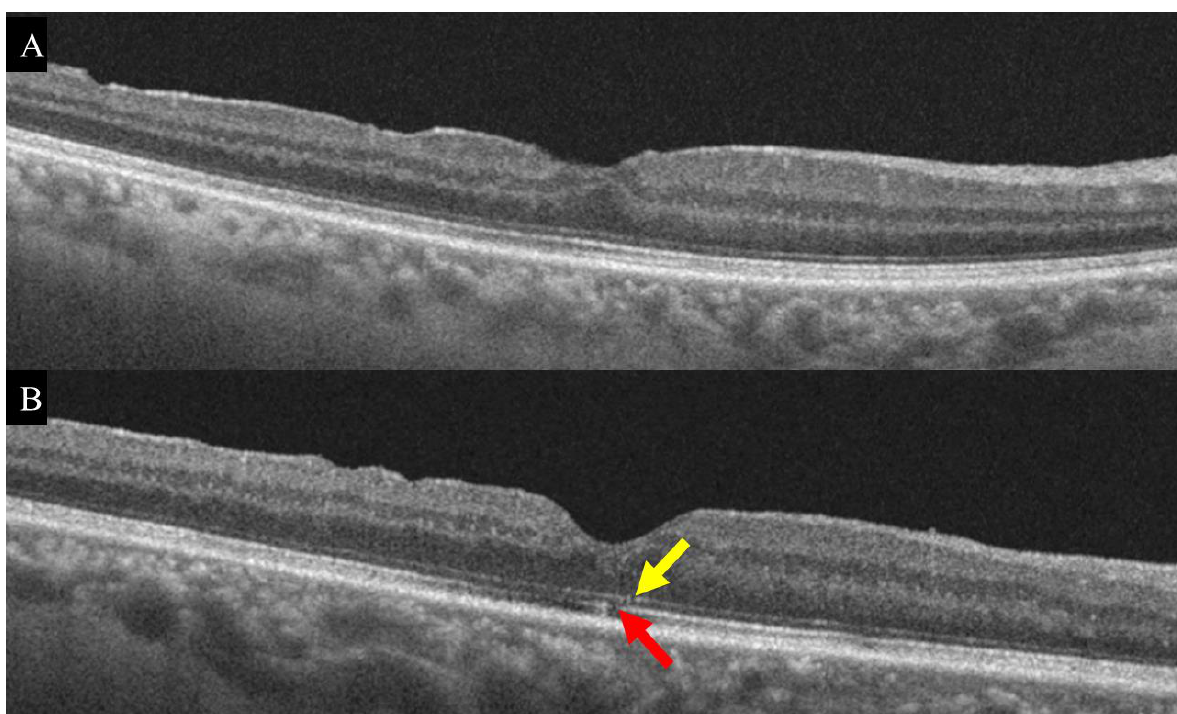
Figure 1. OCT images 6 months after MH surgery. The ELM and EZ lines on OCT maintained continuity without interruption. In this case, the patient was assigned to the nearly recovered group (A). When either the ELM (yellow arrow) or EZ (red arrow) line was broken, patients were assigned to the partially recovered group (B). ELM, external limiting membrane; and EZ, ellipsoid zone.